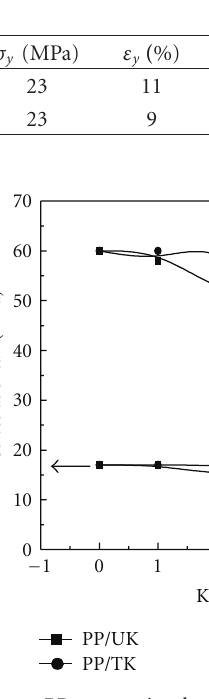
Figure 5: PP composites breaking stress and strain variations as a function of treated and untreated kaolin